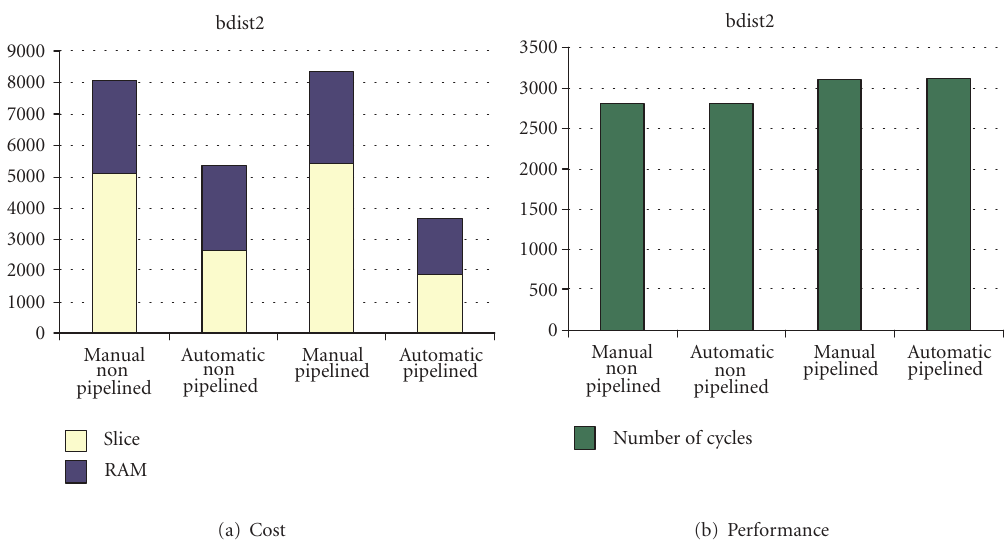
Figure 15: bdist2 : number of slices, number of RAMs, and number of cycles for manually selected and automatically generated data paths.